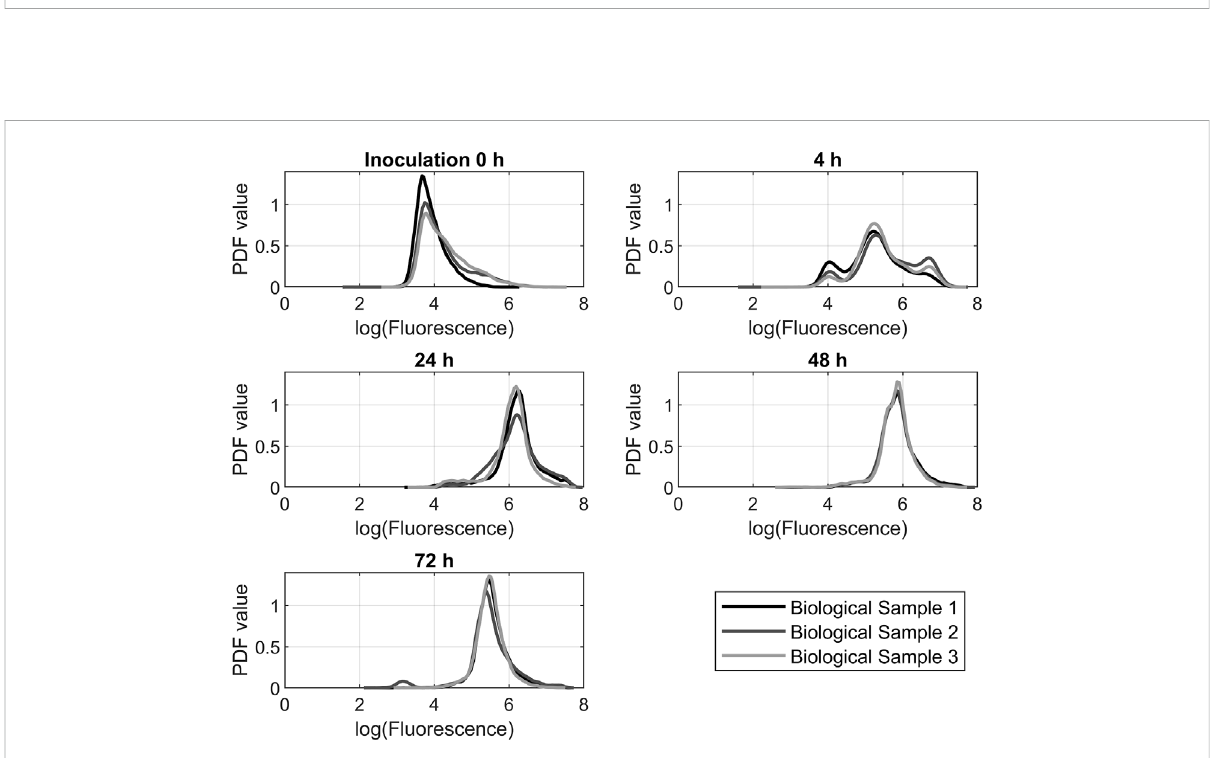
FIGURE 6 Probability density function (PDF) of dihydroethidium fl uorescence data from fl ow cytometry measurements. The data from the 200 rpm propagations was representative of the other experiments.